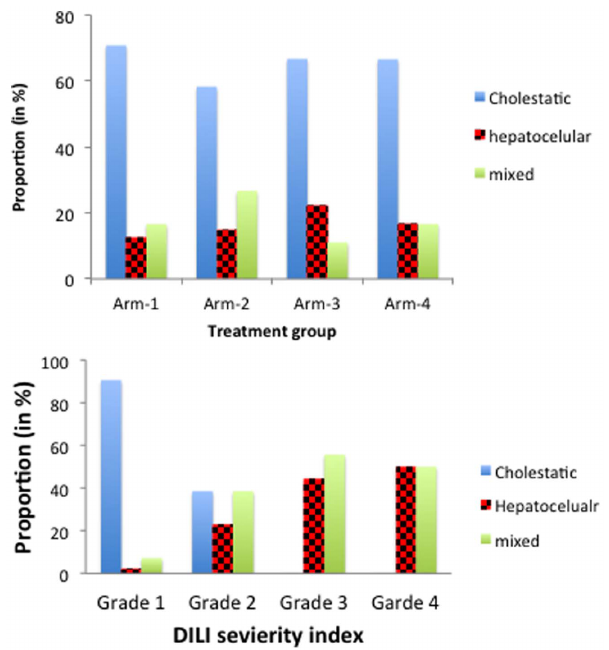
Figure 2. Distribution of the different types of liver injuries (hepatocellular, cholestatic and mixed type) that were ob- served in each treatment group (Figure 2A) and stratified by severity grade (Figure 2B): HIV patients without TB co- infection (Arm-1) treated with efavirenz based HAART alone, TB-HIV co-infected patients with CD4 count # 200 cells/ m L treated with concomitant anti-TB and HAART therapy (Arm-2), TB-HIV co-infected patients with CD4 count . 200 cells/ m L treated with anti-TB therapy alone (Arm-3) and TB patients without HIV co-infection treated anti-TB therapy alone (Arm- 4).